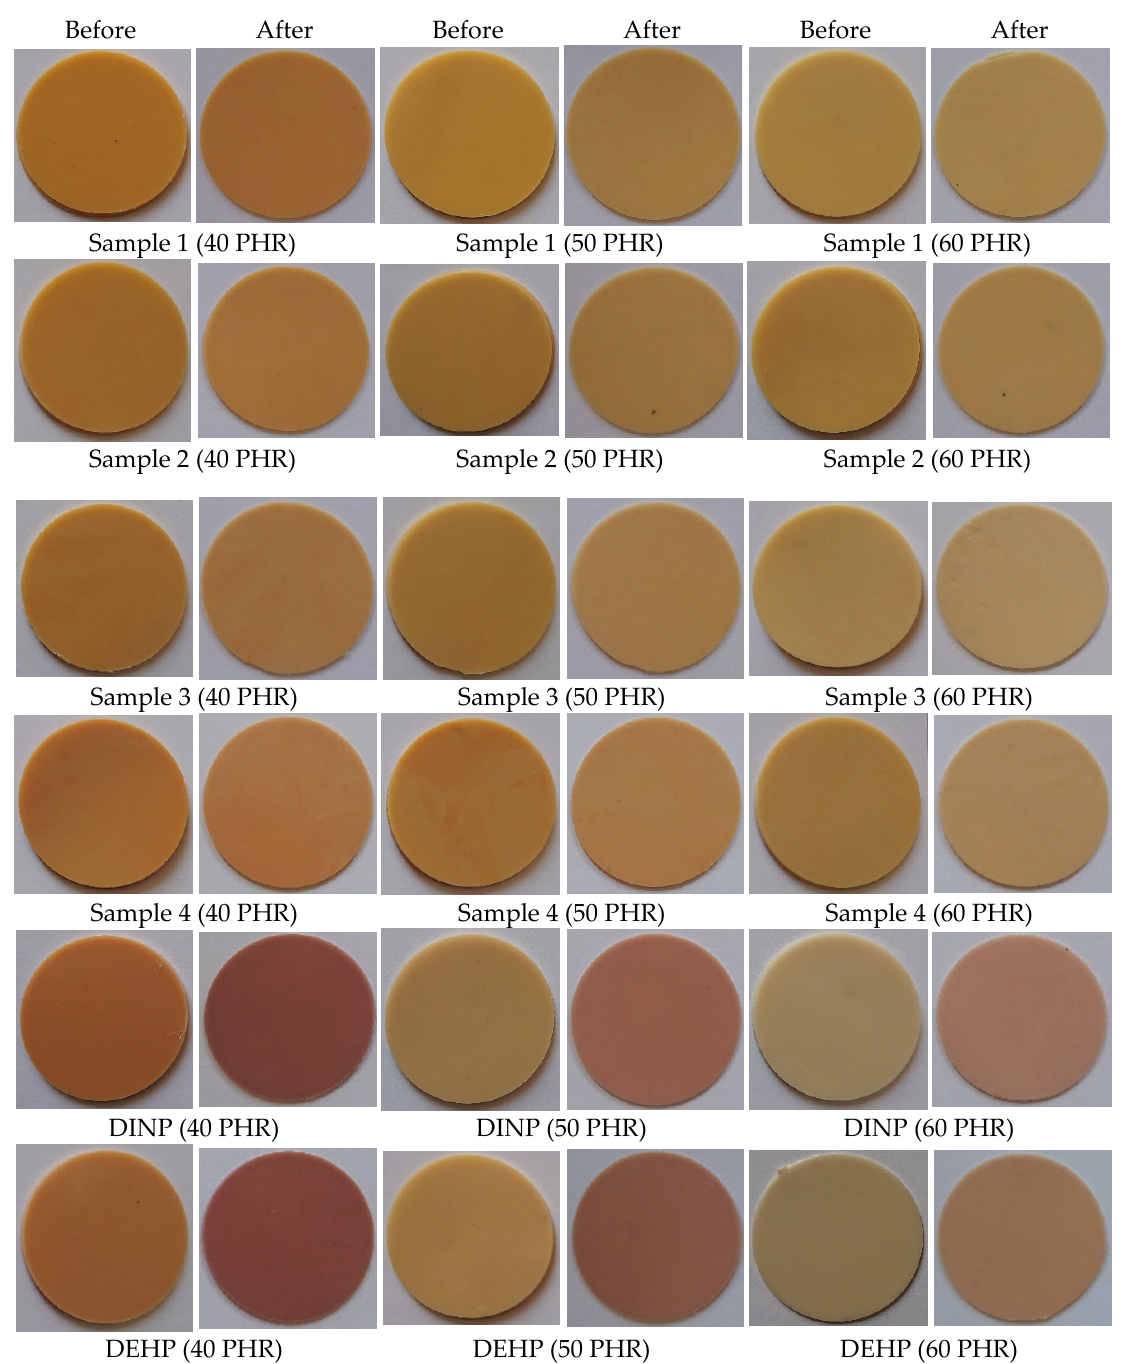
Figure 12. Soft PVC disc appearance–before and after